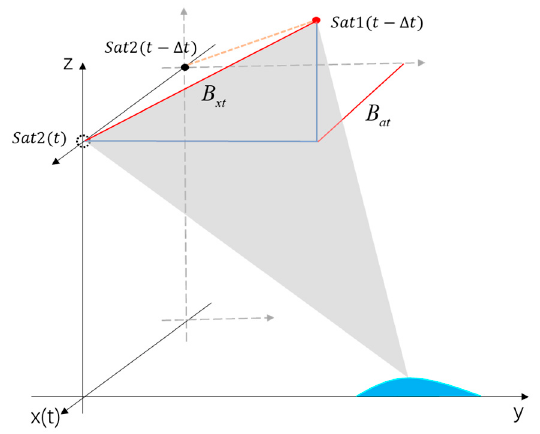
Figure 5. Interferometry by LB-IRA.